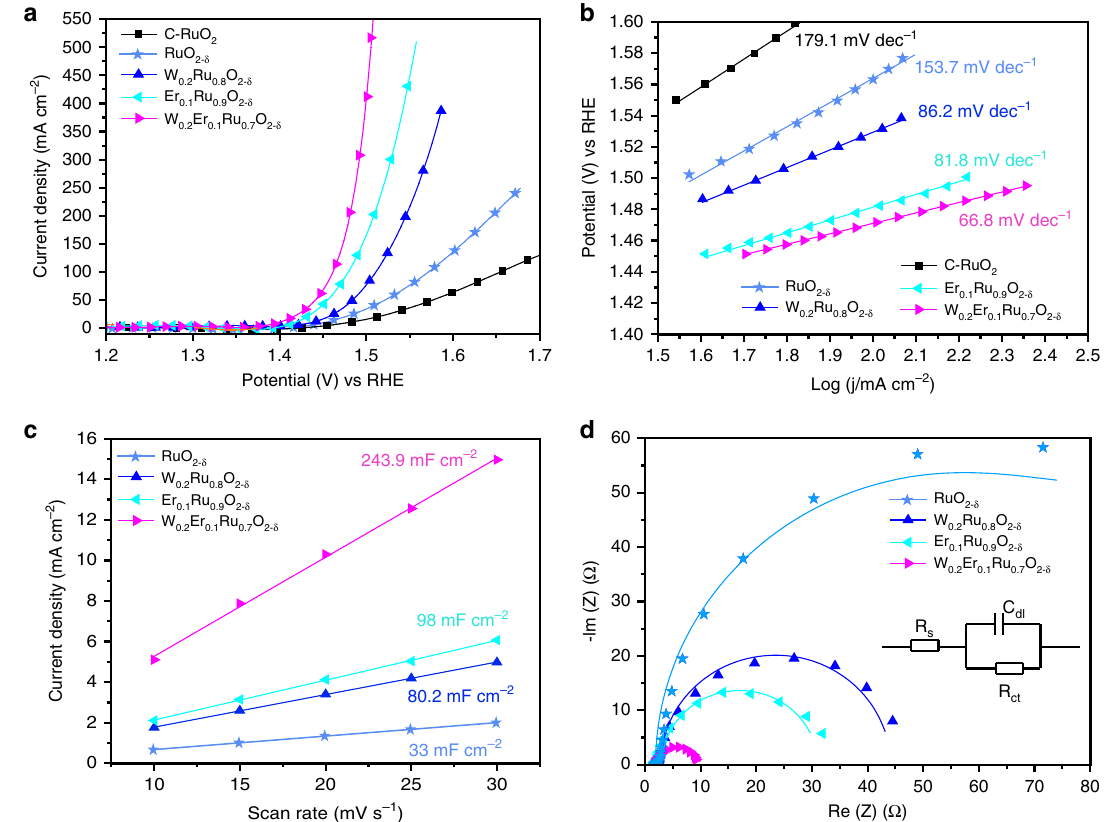
Fig. 6 Acidic OER activities for these samples tested in 0.5 M H 2 SO 4 electrolyte. a Polarization curves, b corresponding Tafel slopes calculated from a . c C dl plots inferred from CV curves. d EIS plots for W 0.2 Er 0.1 Ru 0.7 O 2 − δ , Er 0.1 Ru 0.9 O 2 − δ , W 0.2 Ru 0.8 O 2 − δ , and RuO 2 − δ